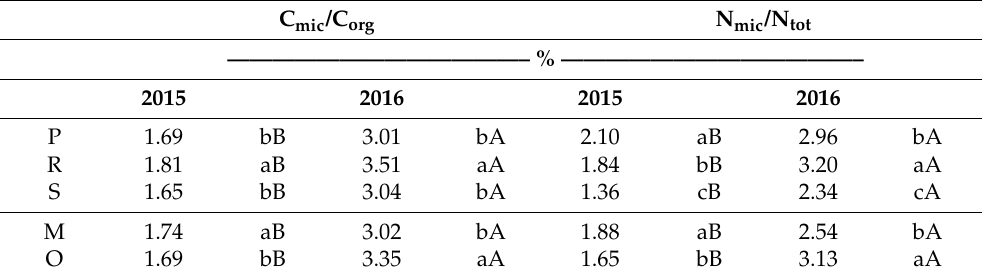
Table 1. Microbial quotients expressed as percentage of microbial-C to total organic carbon (C mic /C org ) and microbial-N to total nitrogen (N mic /N tot ). C mic /C org N mic /N